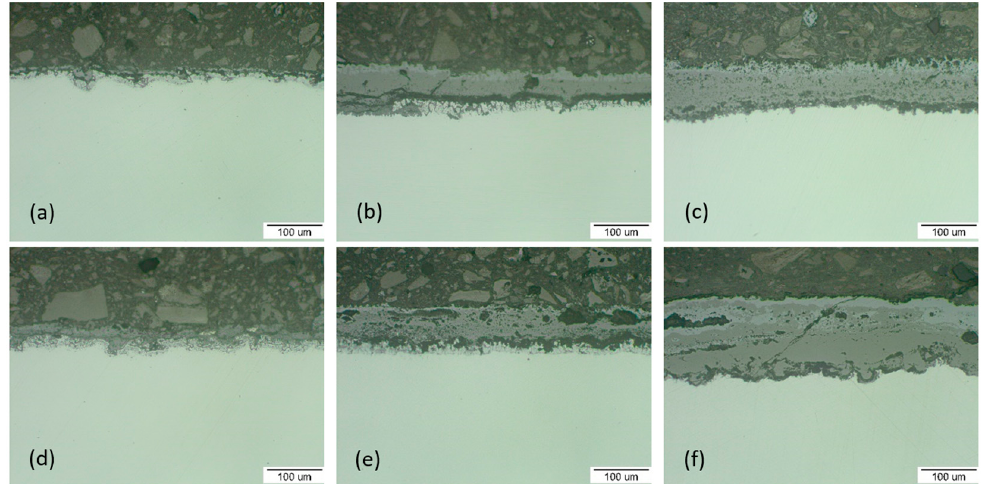
Figure 3. P91 cross-section analysis for: ( a ) 100 h; thickness of the oxide layer 26.93 µm, ( b ) 1000 h; 37.10 µm, ( c ) 3000 h; 107.70 µm and MarBN for: ( d ) 100 h; 34.28 µm, ( e ) 1000 h; 70.71 µm, ( f ) 3000 h; 124.17 µm oxidized at 650 °C.